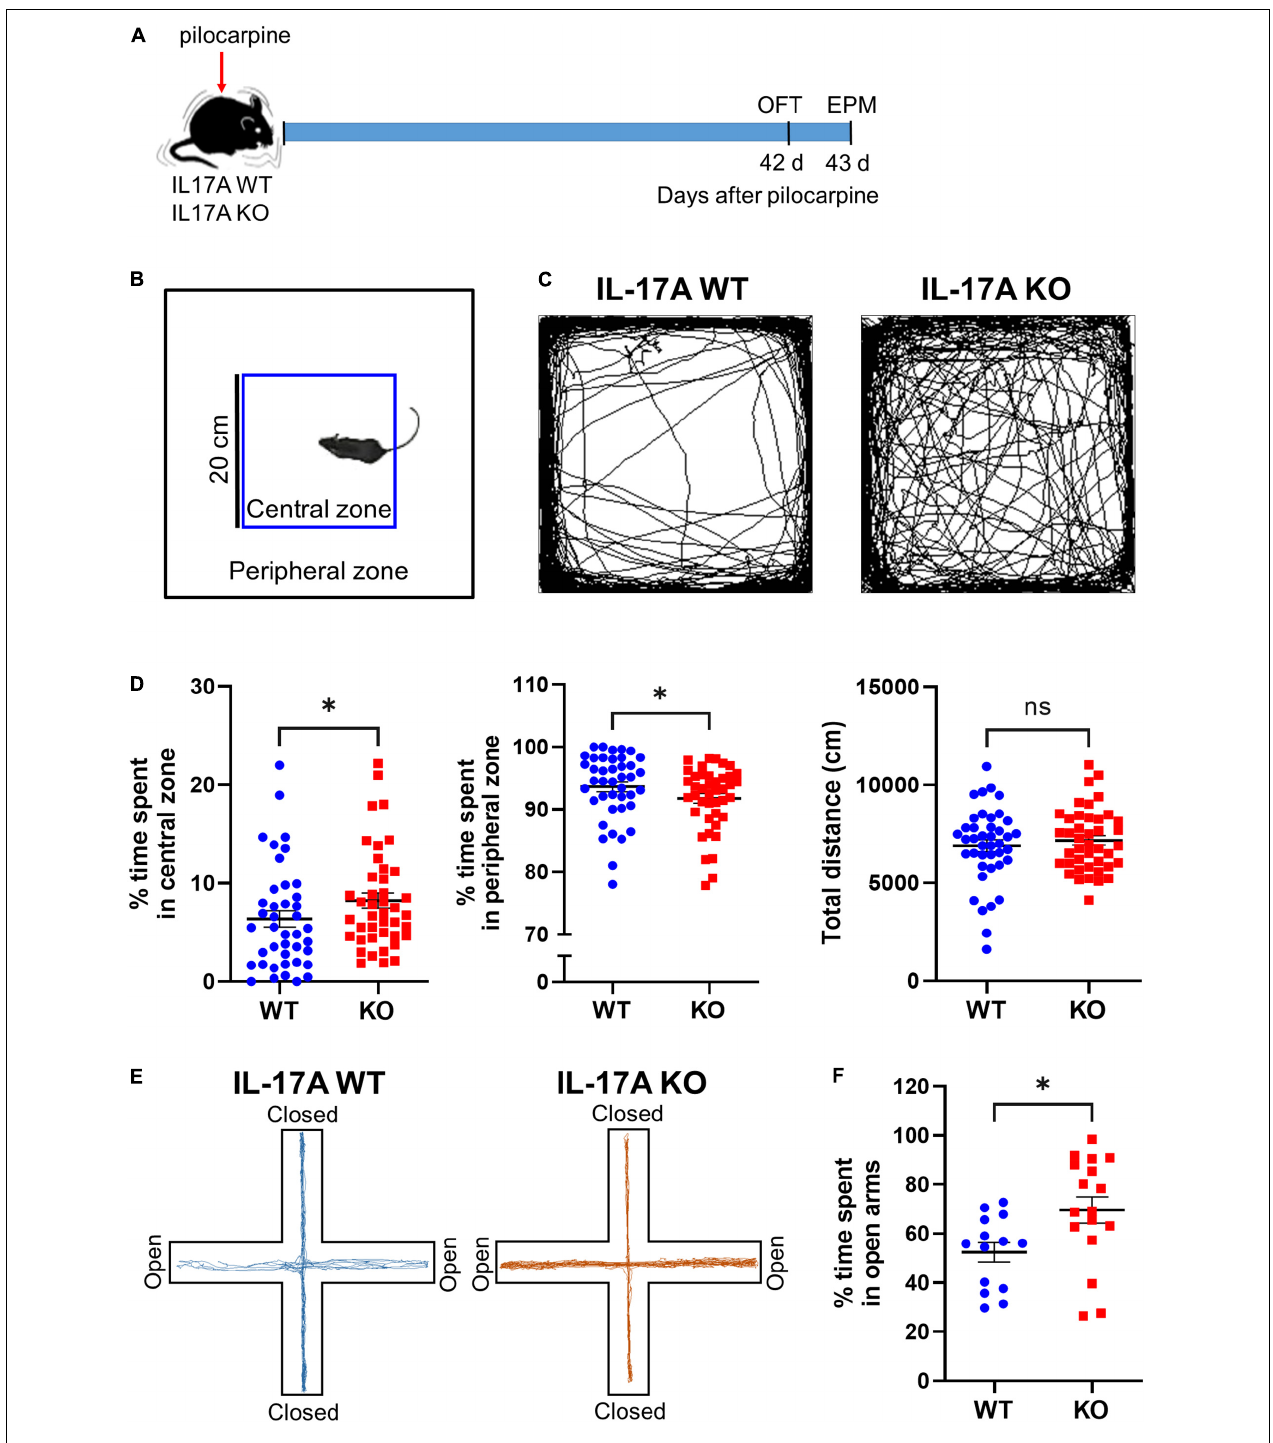
FIGURE 1 | IL-17A deficiency attenuates anxiety-like behaviors in chronic epilepsy in mice. (A) Timeline showing the experimental design. (B) Schematic presentation of central and peripheral zones in the open field arena. (C) Representative traces of IL-17A WT and KO mice showing spontaneous movement in an open field box. (D) Graphs showing the percentage of time spent in the central zone and the peripheral zone and the total distance traveled in the open field. n = 41 (WT) and n = 42 (KO). Detailed statistics are as follows. Central zone: Mann–Whitney U -test, p = 0.044, U = 640.500; peripheral zone: Mann–Whitney U -test, p = 0.044, U = 640,500; total distance: Student’s unpaired t- test, p = 0.481, t (81) = 0.707. (E) Representative traces of IL-17A WT and KO mice showing spontaneous movement in an elevated plus maze. (F) A graph showing the percentage time spent in the open arms of the elevated plus maze. n = 14 (WT) and n = 17 (KO). Student’s unpaired t- test, p = 0.019, t (29) = 2.492. Data are presented as mean ± SEM. ∗ p < 0.05, NS, not